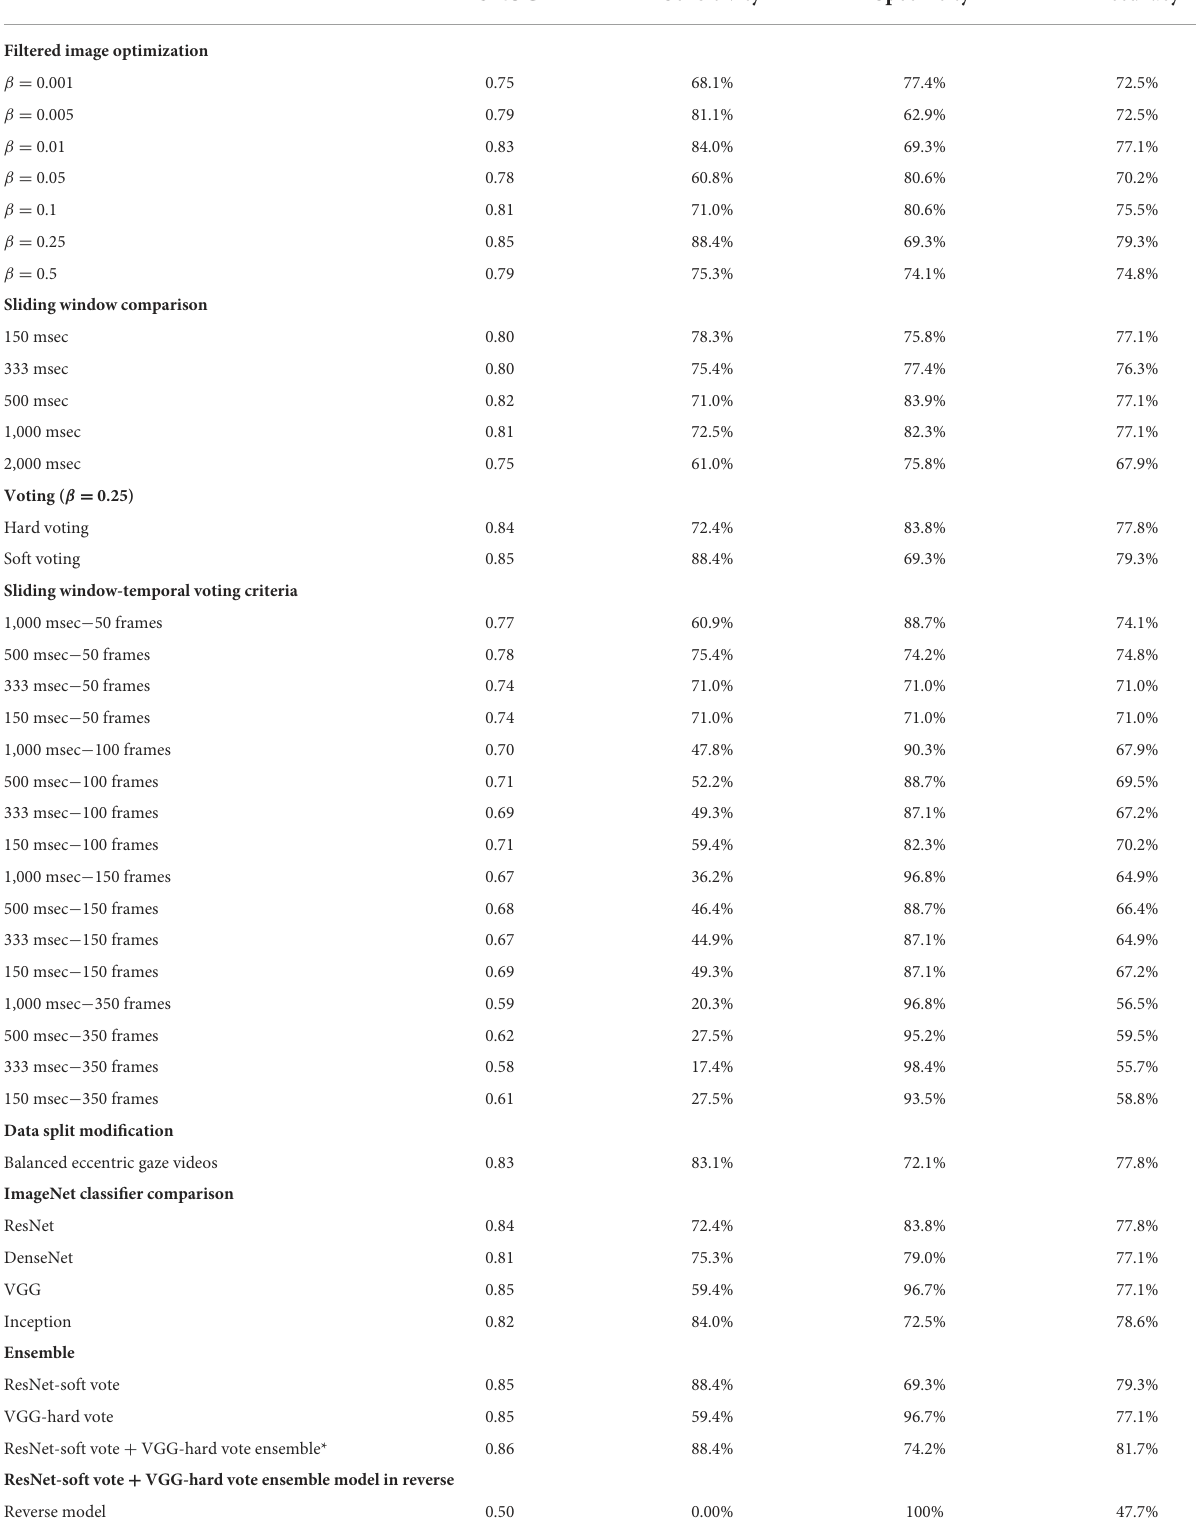
TABLE 1 Performance metrics for model experiments. AUROC Sensitivity Specificity